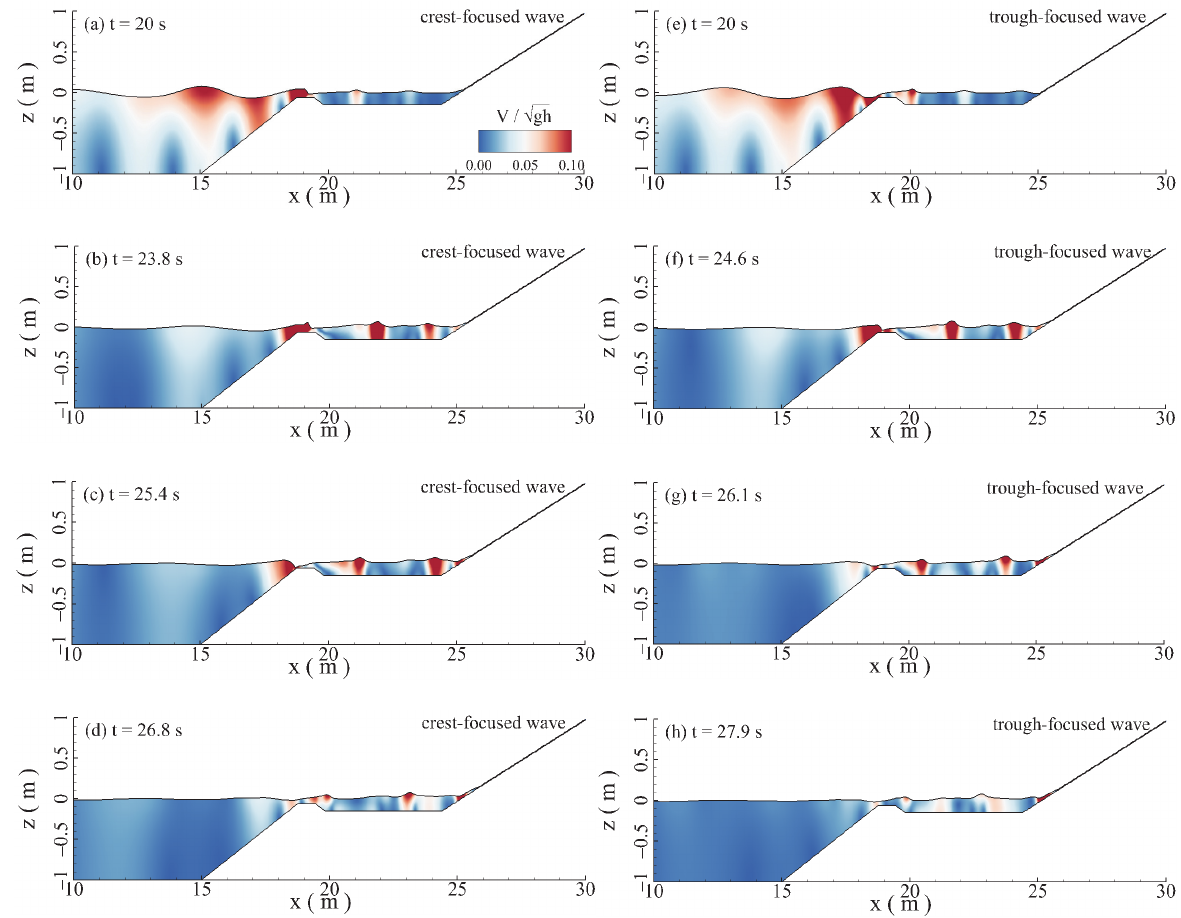
Figure 7. Water velocity contours at different time moments; left side : crest-focused wave; right side : trough-focused wave.